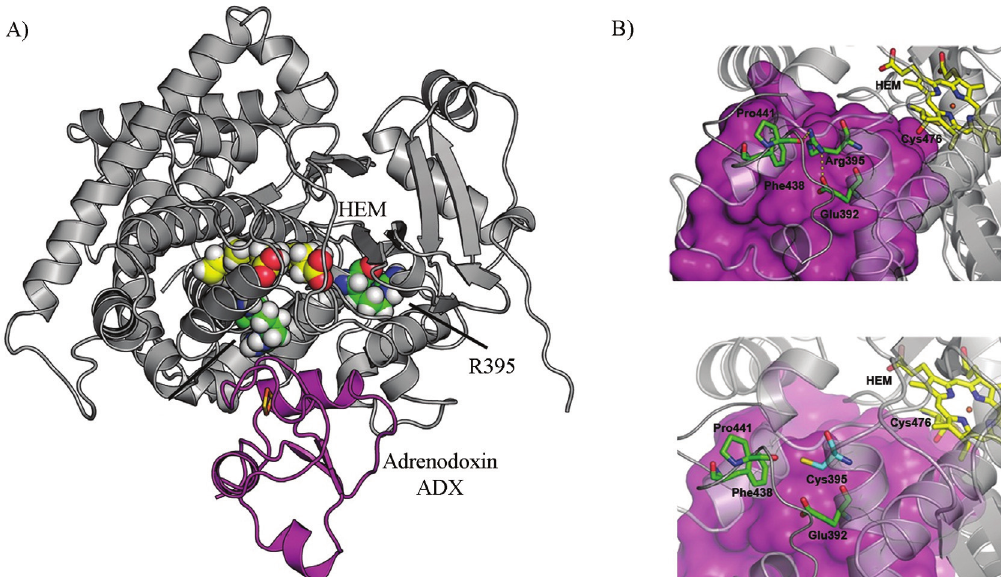
Figure 2 - CYP27A1 modeling. A) Tridimensional model of wild type protein CYP27A1 showing HEM group and position of Arg395. B (upper panel): Enlargement of amino acids region showing that Arg395 interacts with Phe438 by pi-cationic interaction and is also involved in H-bond interactions with the carboxyl group of Glu392 and the main-chain nitrogen from Pro441. B (lower panel): Mutation to Cys395 will increase distances and the interactions loosened will favor misfolding, which may affect ADX